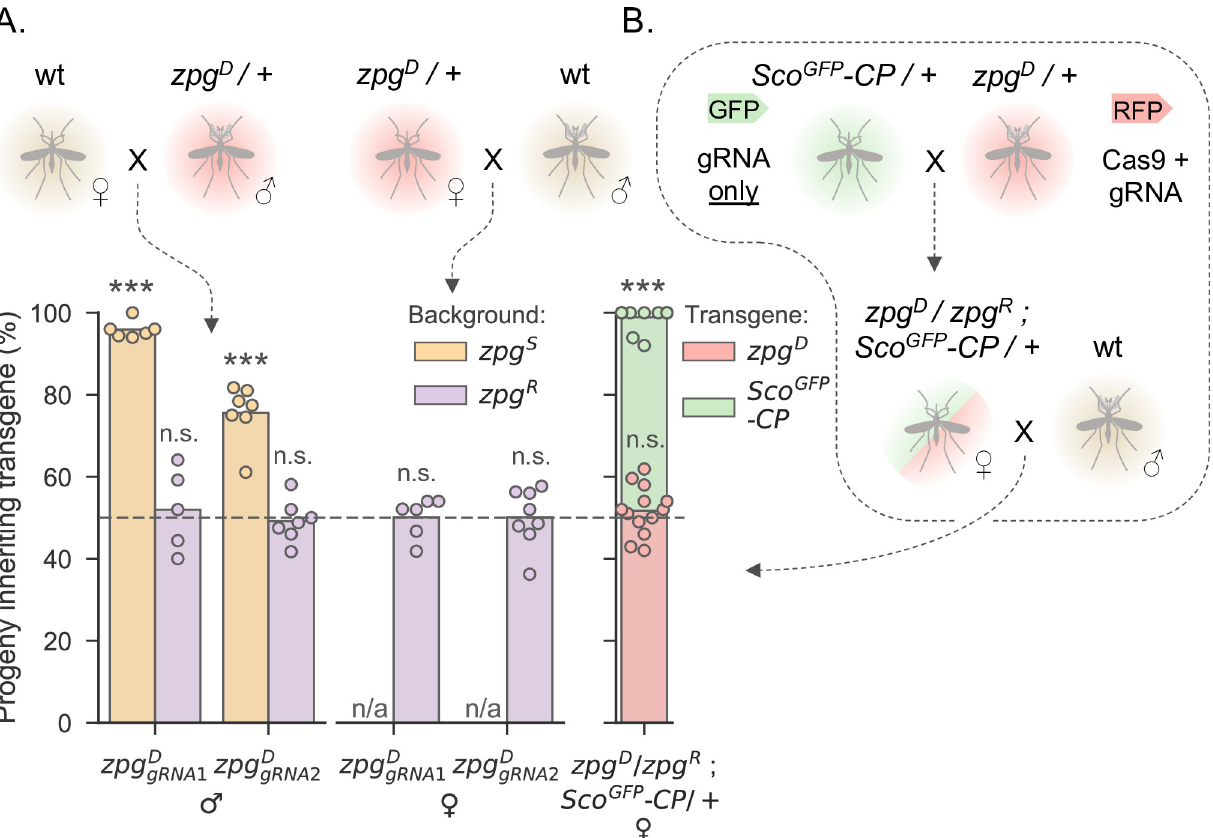
Fig 2. zpg D produces functional Cas9 and homes in a susceptible genetic background, but zpg D / zpg S females do not produce offspring. A : Proportion of progeny inheriting the zpg D transgene from single crosses between hemizygous and wild-type mosquitoes. Left : Hemizygous males expressing gRNA1 or gRNA 2 crossed to wild-type females. Right : Hemizygous females expressing gRNA1 or gRNA 2 crossed to wild-type males. The transgenic parent from each cross was genotyped by Sanger sequencing to determine the genetic background of the transgene in that individual–those with susceptible alleles ( zpg S ) are shown in orange, whereas those with resistant allele are in purple ( zpg R ). Males expressing both gRNA1 and gRNA2 in a susceptible background sired significantly more transgenic progeny than 50% (gRNA1: t = 51.861, p < 0.0001; gRNA2: t = 9.749, p < 0.0001; one sample t-tests). In crosses with hemizygous females, none of the females producing viable progeny had a zpg S genetic background. B : Female zpg D individuals produce active Cas9 that allows non-autonomous homing of un-linked construct in a zpg R background. The progeny of a cross between wild-type males and females hemizygous for zpg D and a non-autonomously homing transgene at the cp locus (Sco GFP -CP) were screened for the inheritance of each transgene. Females sired significantly more Sco GFP -CP progeny than 50% (t = 65.913, p < 0.0001; one sample